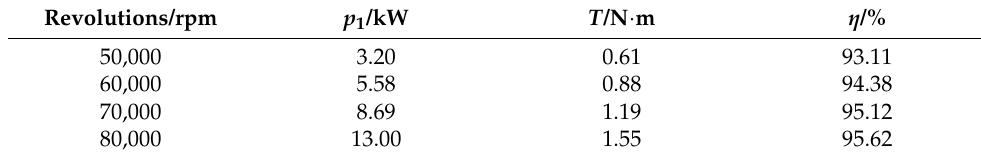
Table 4. Test results of air compressor